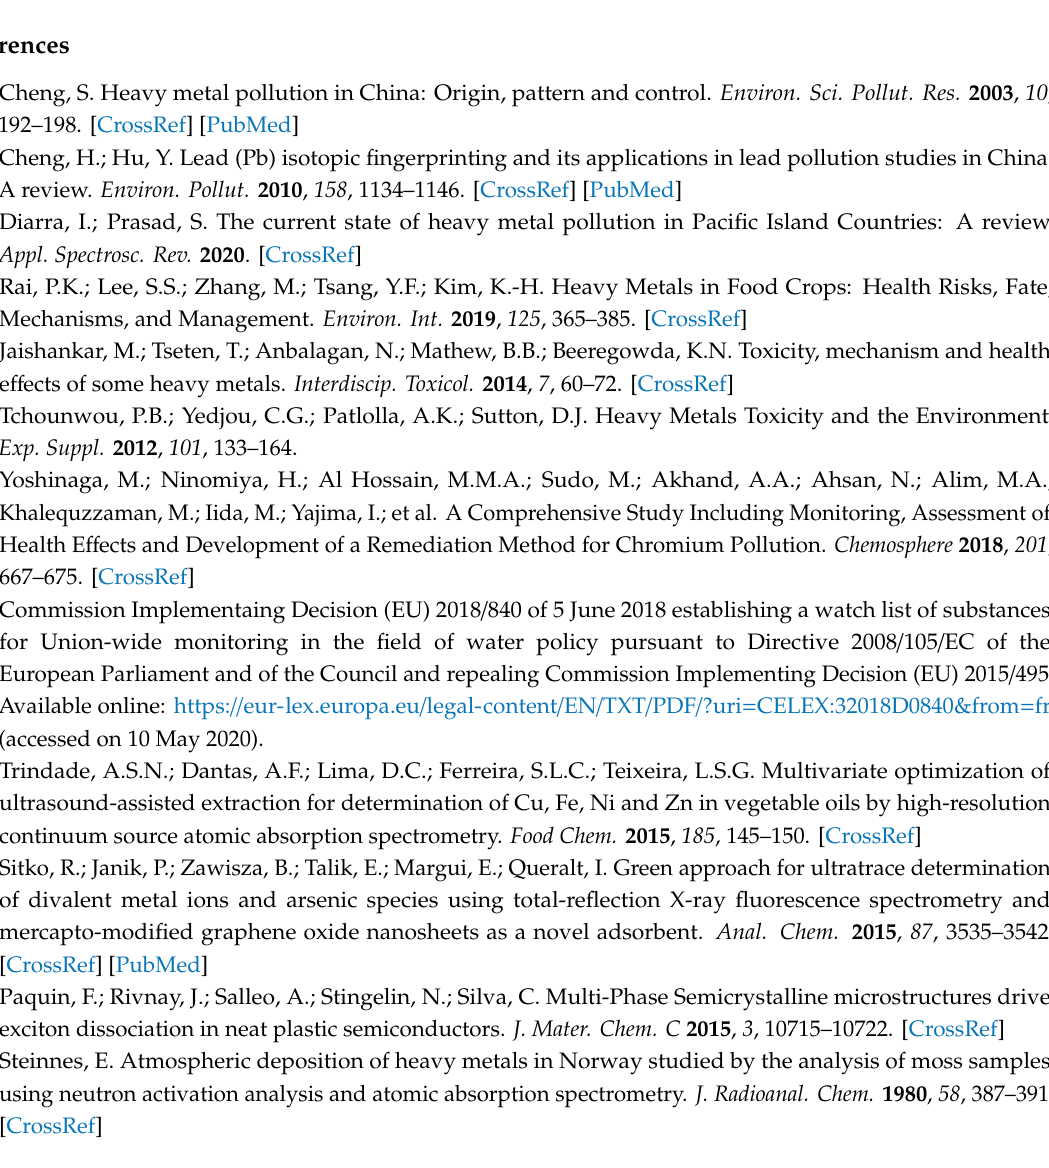
Figure S1: Representative NMR data of protons related to the chemical structures of synthesized monomers and polymers, Figure S2: TGA thermograms of resulting polymers P1–P4 under nitrogen, Figure S3: DSC heating curves of resulting polymers P1–P4 under nitrogen, Figure S4: AFM image of the P1-modified gold electrode, Figure S5: Relative variation of the Pb 2 + signal after one adsorption-desorption cycle every